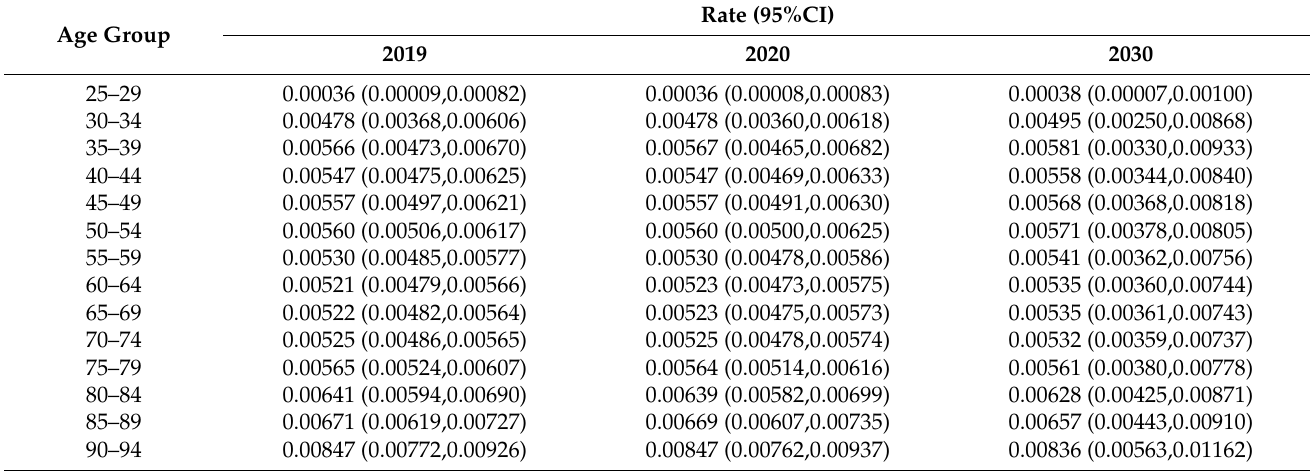
Table 3. Projected mortality rate and corresponding 95%CI for females in selected